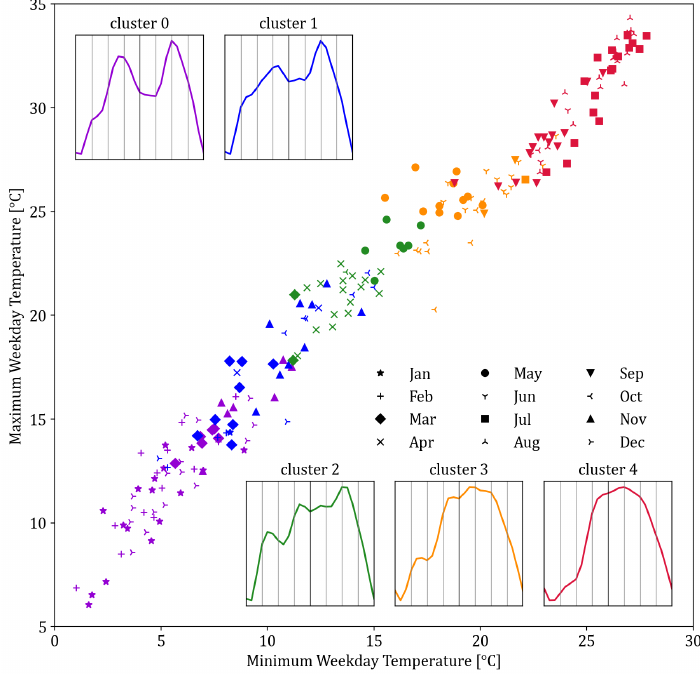
Figure 4. The weekly demand clusters of Kyushu from